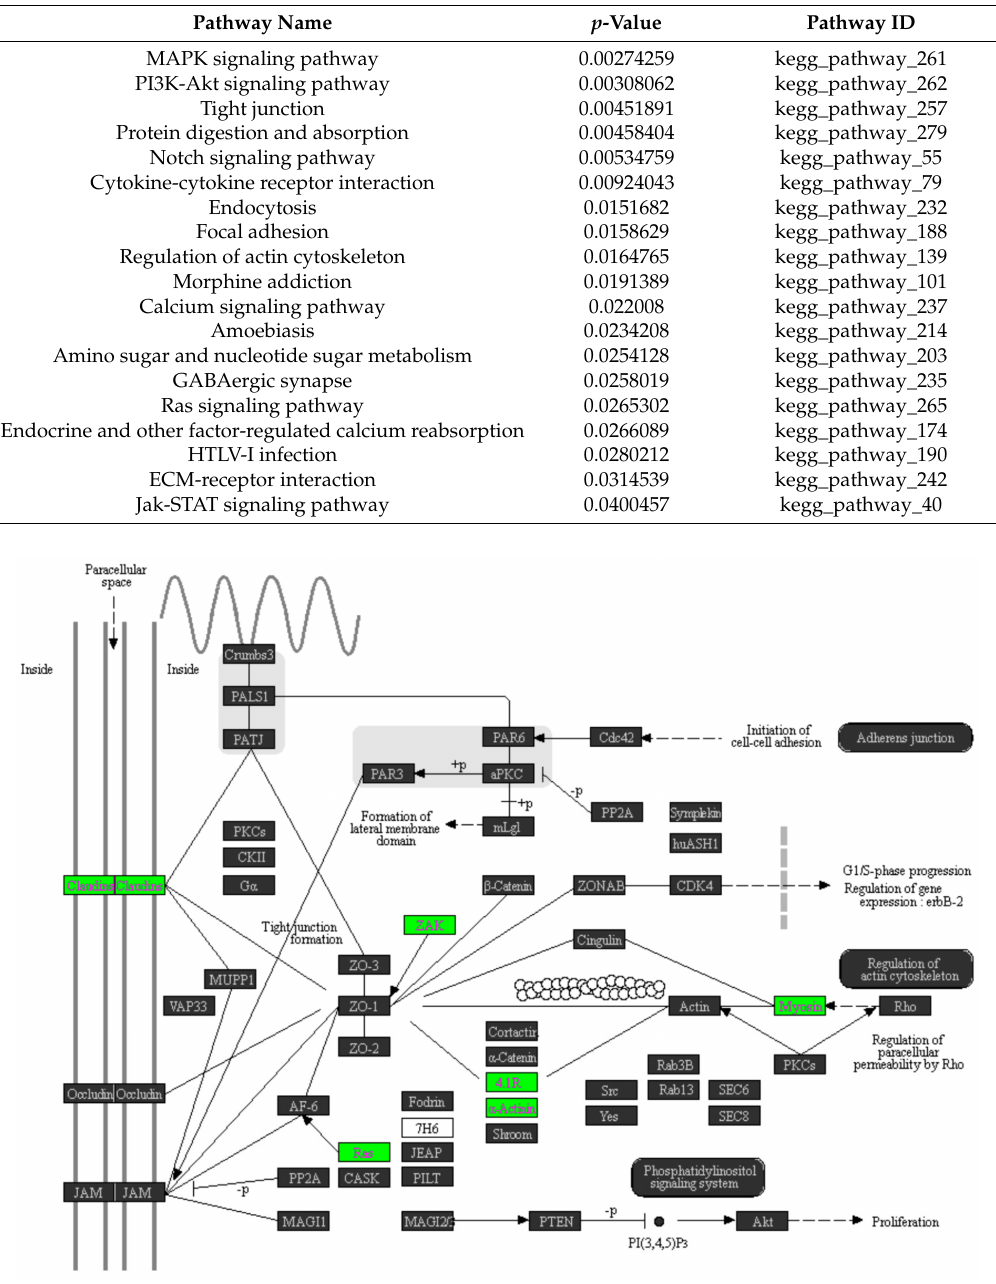
Table 1. Result of pathway enrichment analysis on the 259 downregulated genes. We identified 19 significant pathways, the p -values, pathway names, and KEGG pathway IDs of which are provided.